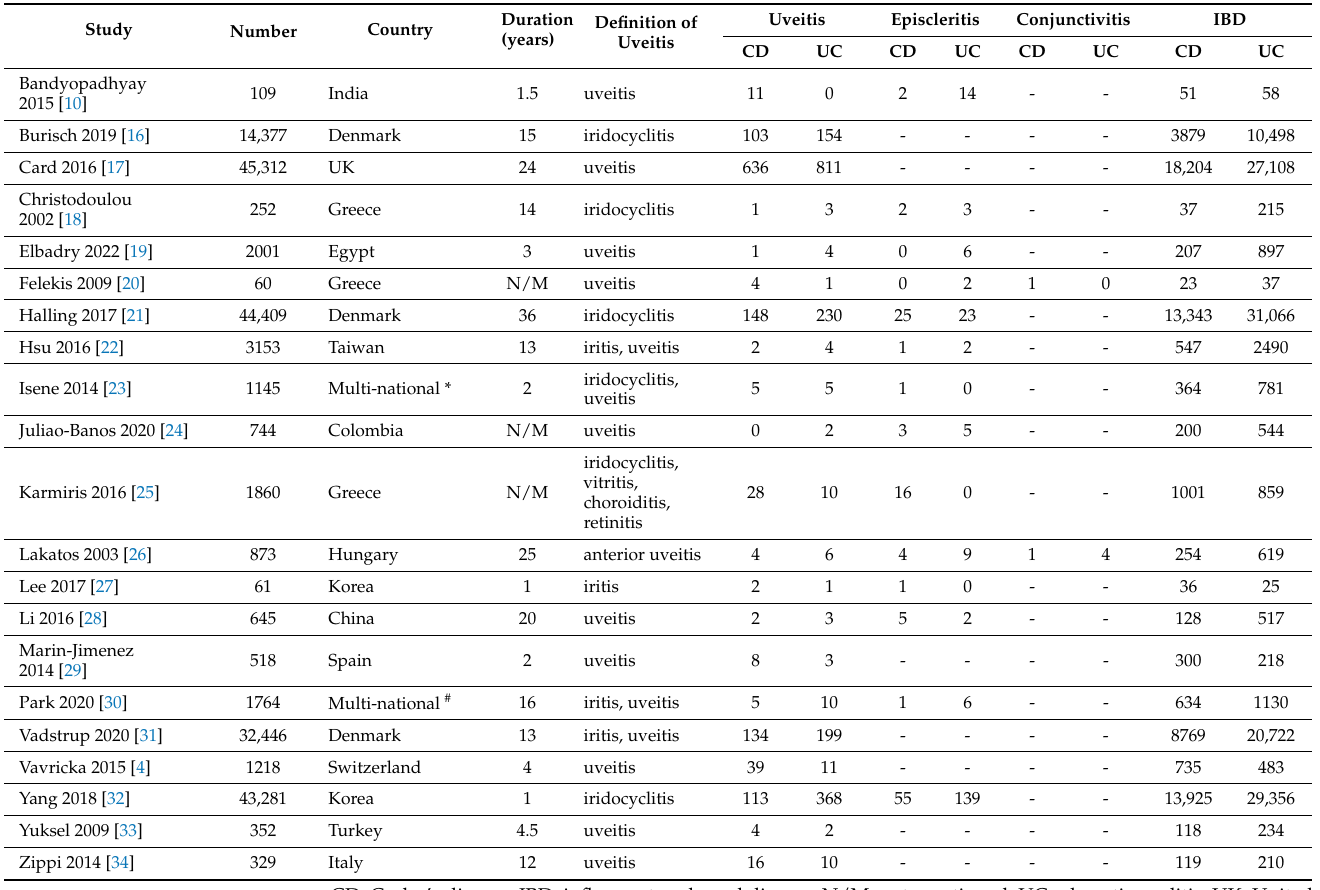
Table 1. Overview of included